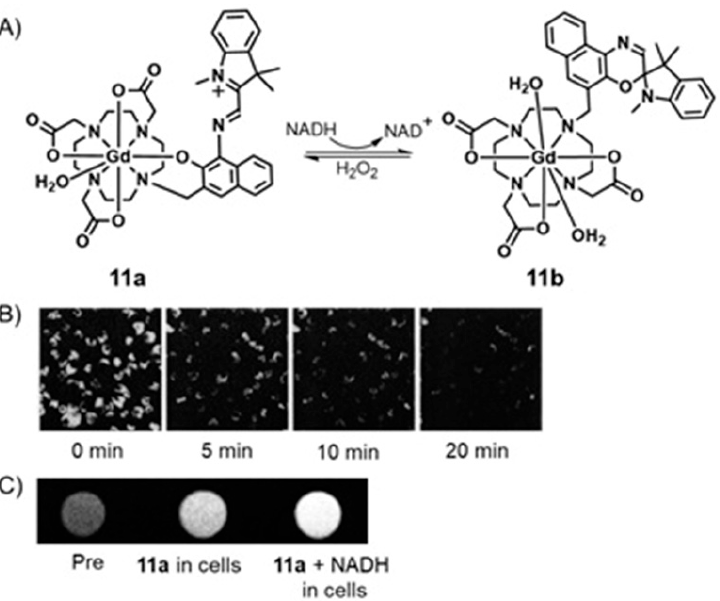
Figure 23. ( A ) The isomerization of complex 11 triggered by NADH and hydrogen peroxide. ( B ) Fluorescence images of P388D1 murine macrophages incubated with complex 11 obtained during the reaction with NADH (concentration of 11 = 0.103 mM, Gd/NADH molar ratio = 1:1). ( C ) T 1 -weighted MRI images of aqueous solutions of 11 immediately after addition of NADH (molar ratio between Gd III and NADH = 1:1). Adapted with permission from Tu, C.; Nagao R.; Louie, A. Y. Angewandte Chemie International Edition , John Wiley and Sons